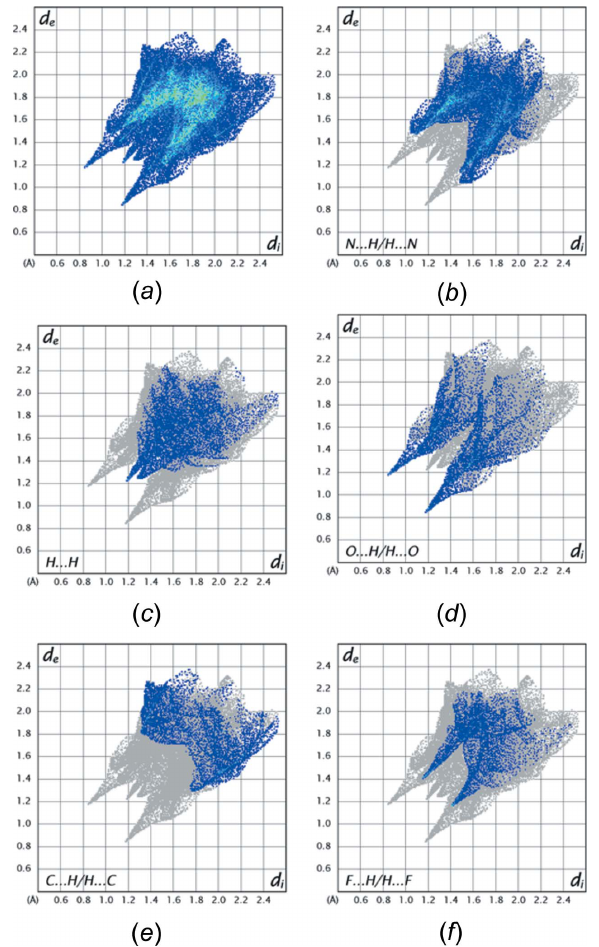
Figure 6 Fingerprint plots for the molecule containing O1 showing